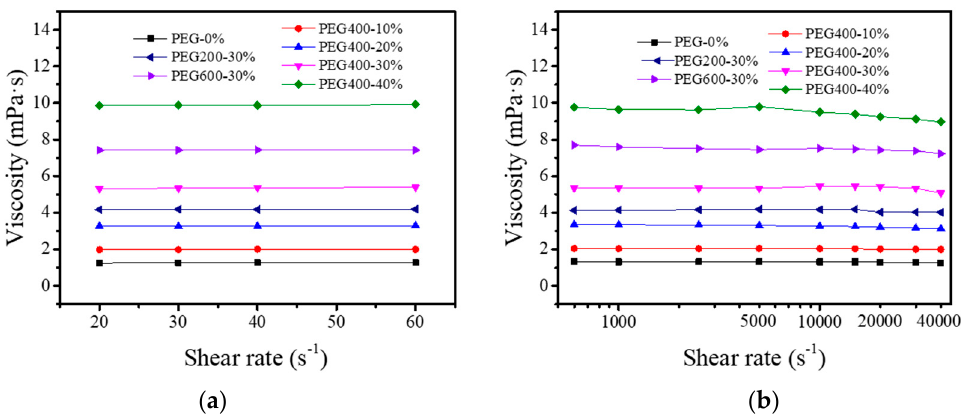
Figure 4. The rheological properties of Red 218 dye inks at different PEG400 concentrations and PEG molecular weights. ( a ) At low shear rates; ( b ) At high shear rates. Red 218 concentration was 7%, and the temperature was 25 °C.